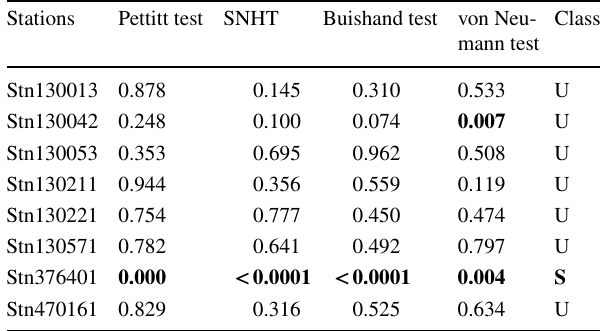
Bold number represents p < 0.05 indicating inhomogeneity in the